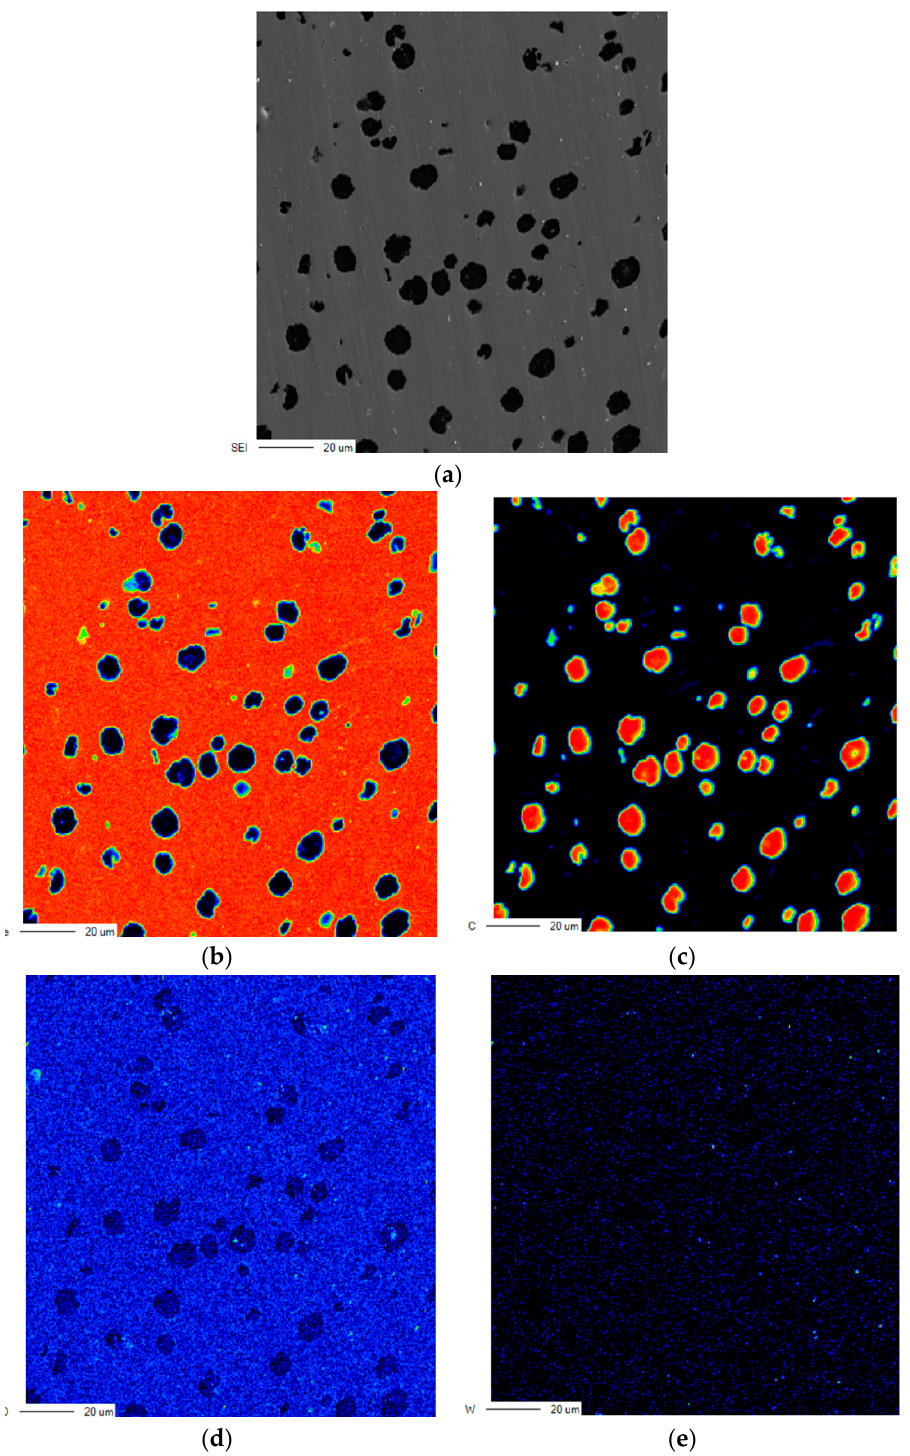
Figure 10. Elemental distribution analyzed by EPMA on the surface of DCI passivated for 72 h in tap water with 100 k ppm tungstate at room temperature. ( a ) SEM image, ( b ) Fe, ( c ) C, ( d ) O, ( e ) W.